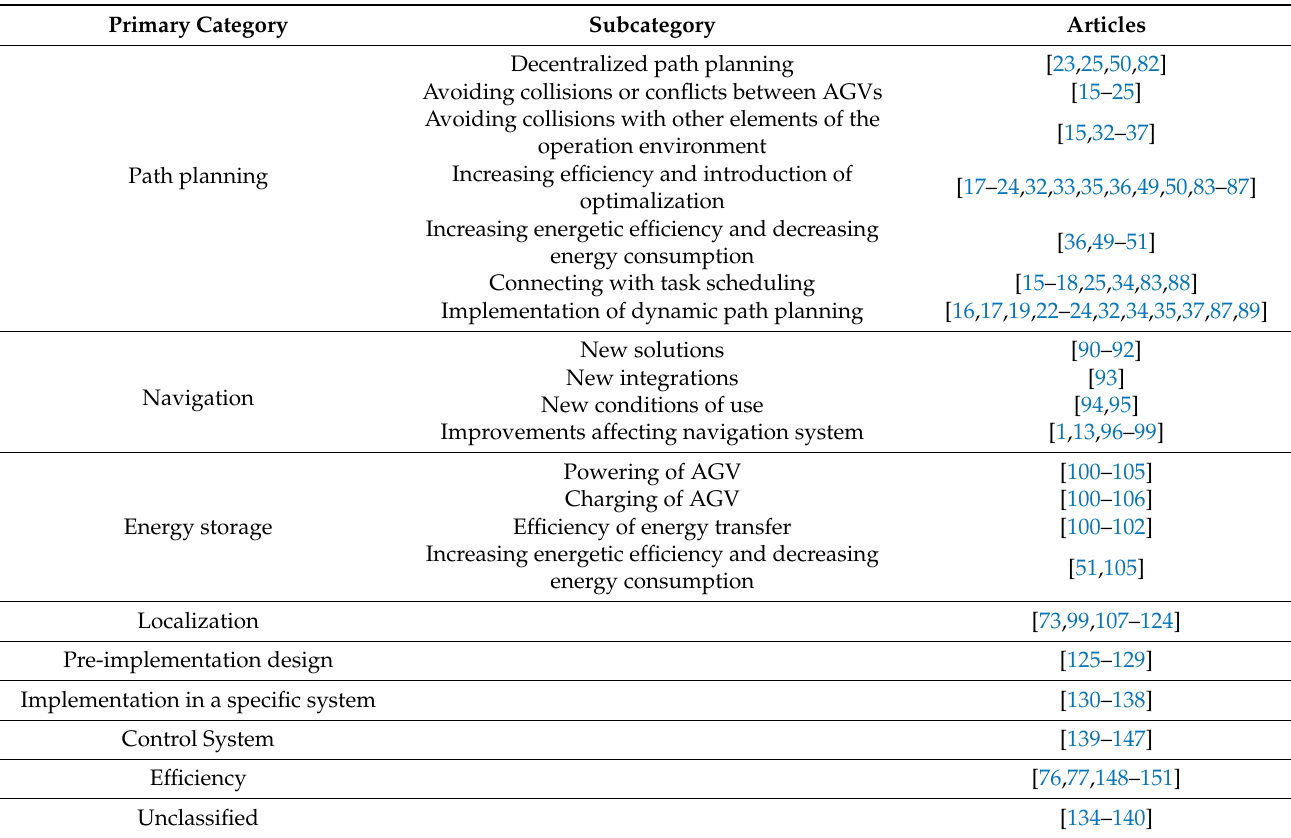
Table 4. Articles divided into primary categories and